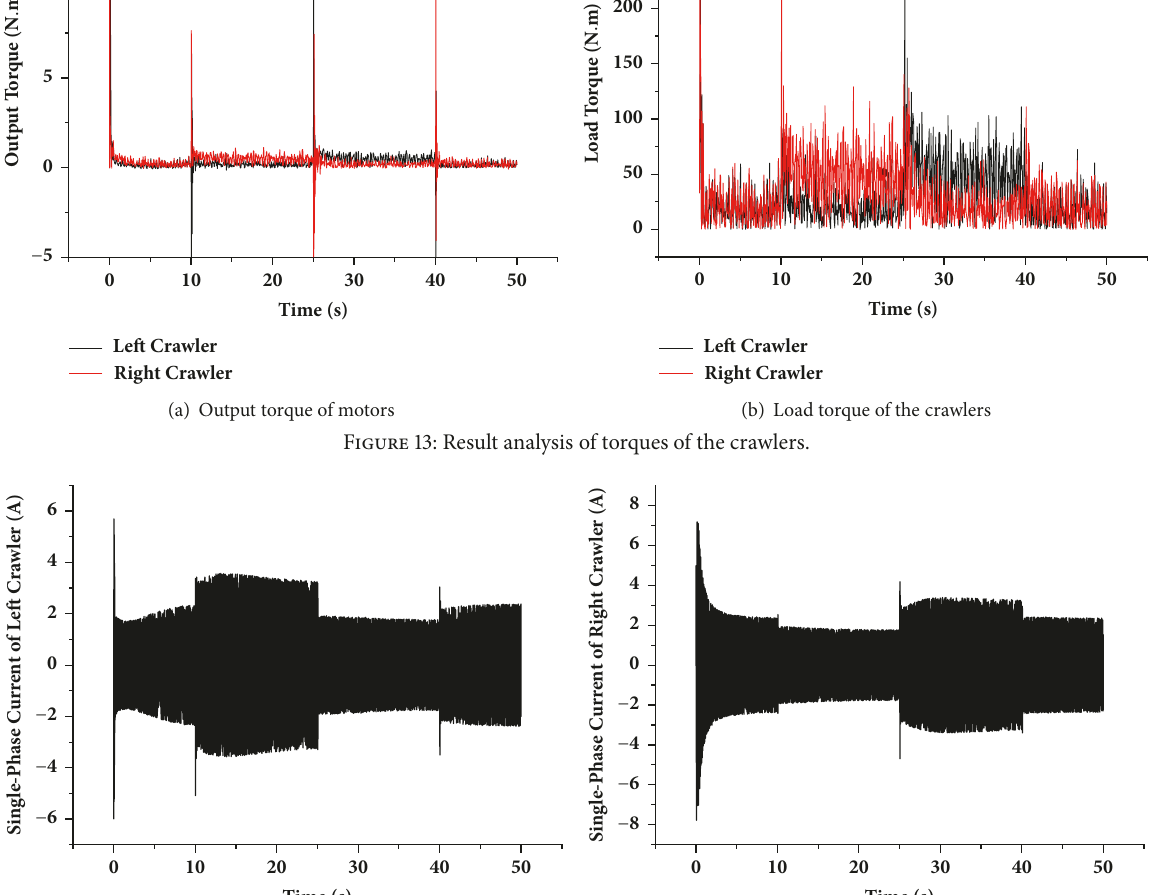
Figure 12: Velocity analysis of the crawlers.